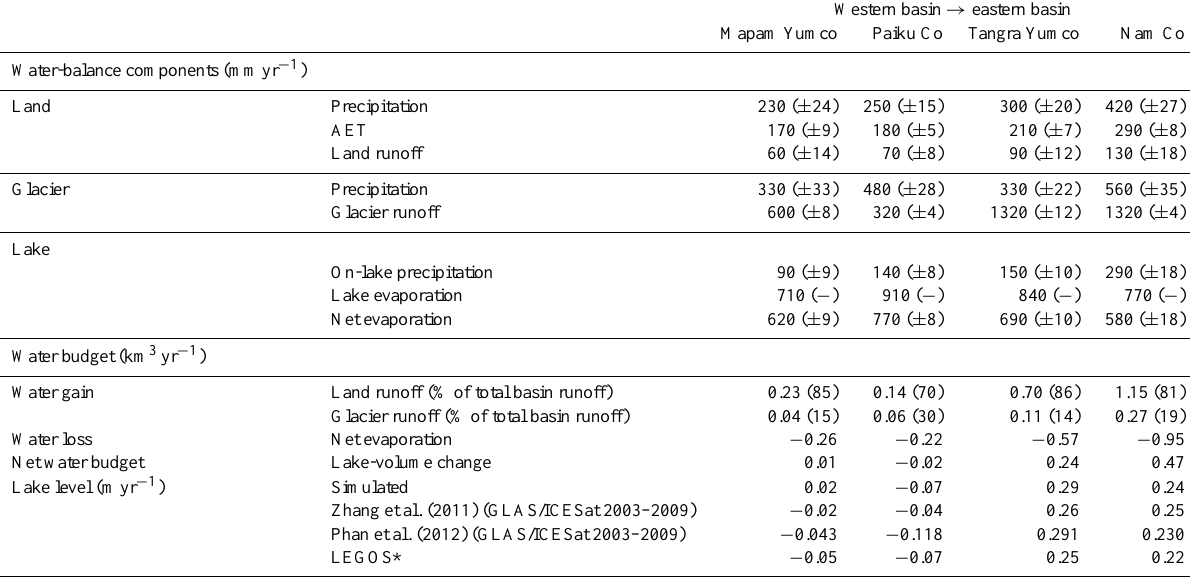
Table 4. Mean annual water-balance components, water budget and lake-level changes for the four studied lake basins for the study period 2001–2010 derived from the reference run. The variation ranges of the mean annual water-balance components correspond to model runs with precipitation-scaling factors ±